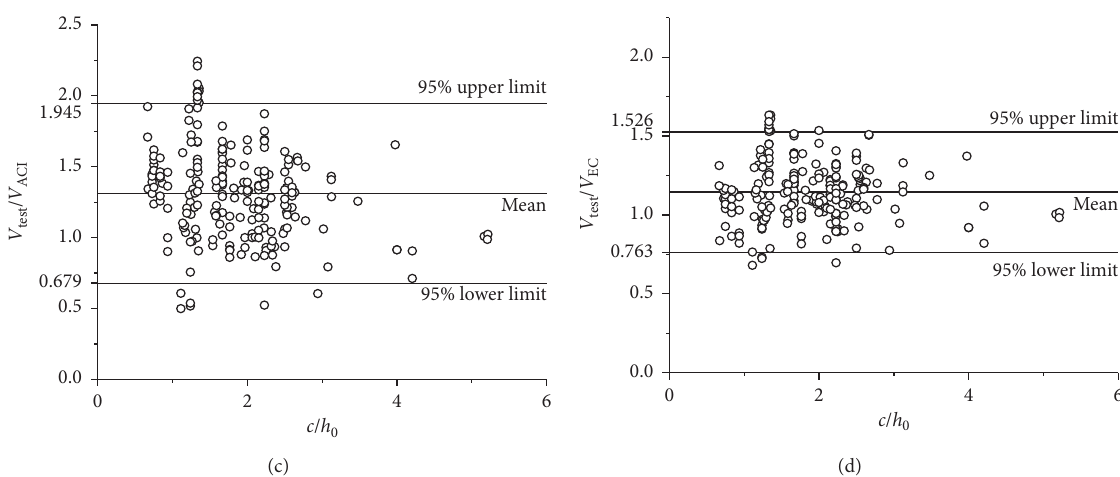
Figure 7: Influence of c / h on the ratio of the test value to the predicted value. (a) BPNN model. (b) GB 50010-2010. (c) ACI 318-14. (d) EC 2-04. 0